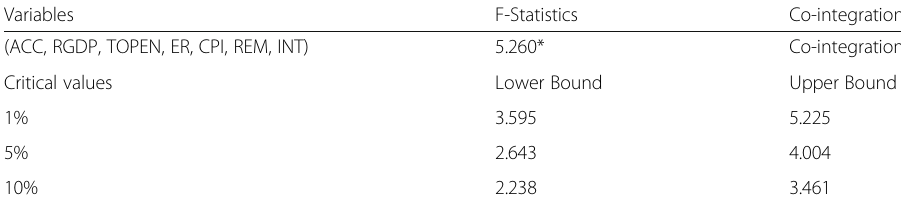
Table 5 Number of bank accounts is the dependent variable Variables